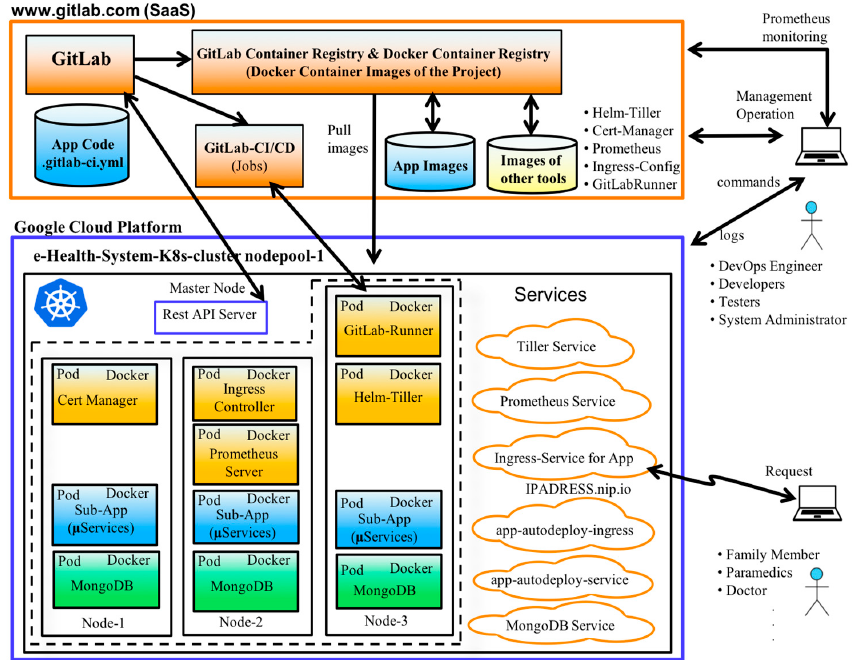
Figure A2. Detailed view of the deployment of the e-health subapplication microservices in the cloud from the GitLab repository.